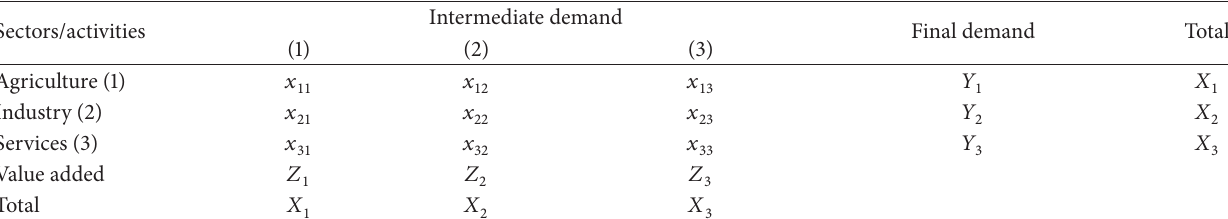
Table 1: Structure of input-output